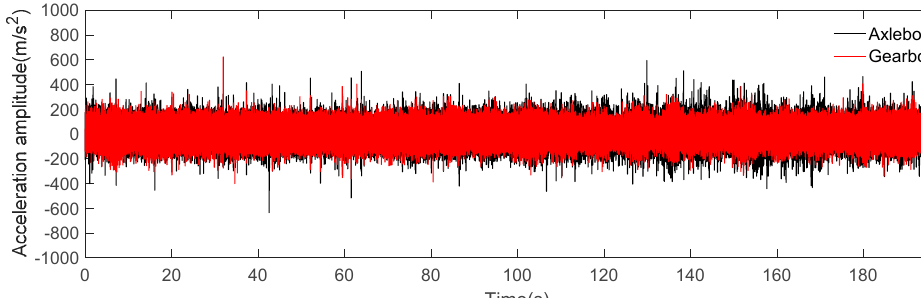
Figure 7. Vibration of gearbox and axle box.